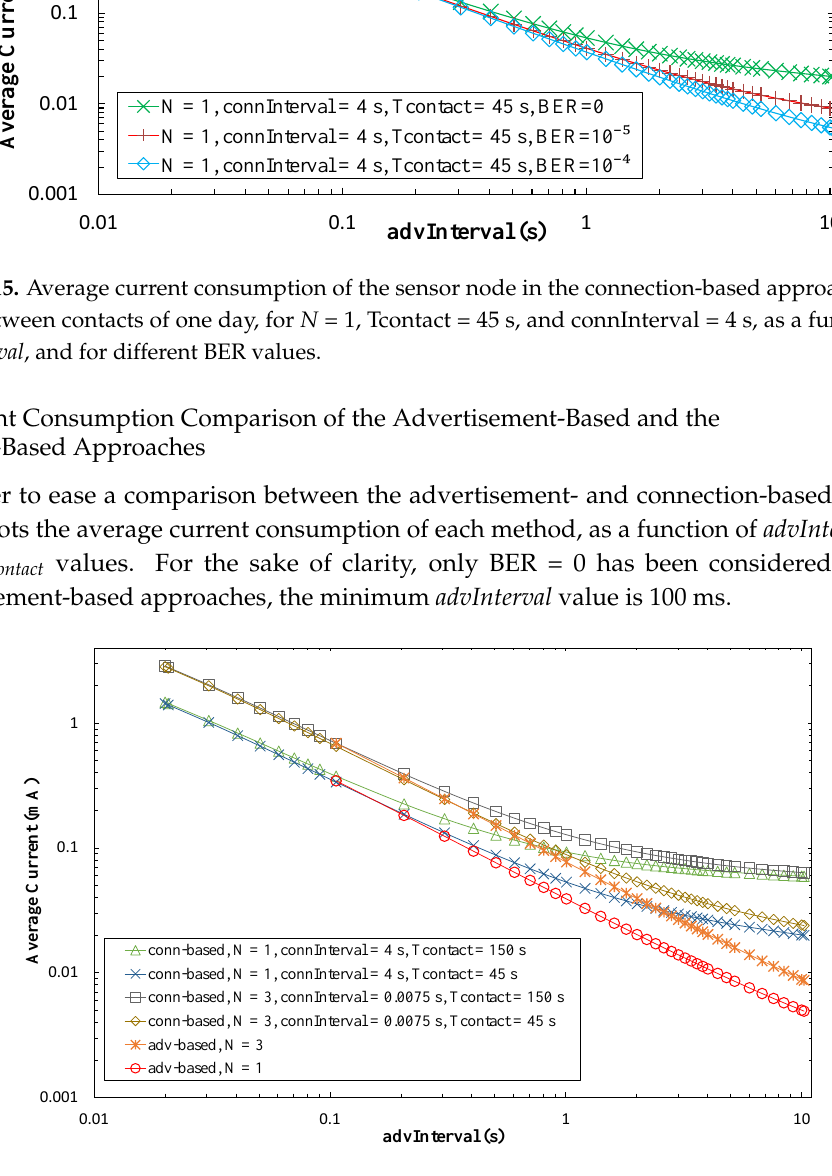
Figure 14. Average current consumption of the sensor node in the connection-based approach, for a time between contacts of one day, as a function of advInterval , and for different N and T contact , and for BER = 0. A theoretical value of T contact = 0 has been evaluated, however depicted results in the logarithmic representation used in the figure are very close to those of T contact = 45 s. Thus they have been excluded from the figure for the sake of clarity.